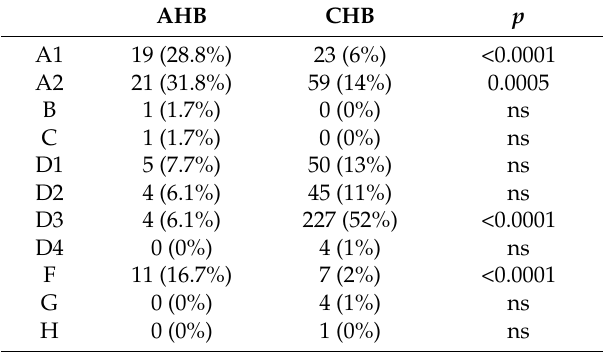
Table 2. Differences in genotype/subgenotype prevalence in AHB and CHB patients from the same clinical center in